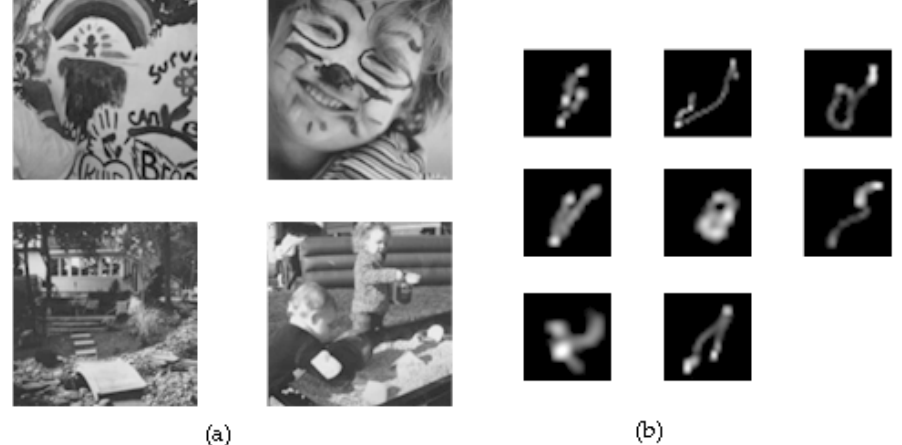
Figure 7. The Levin library; ( a ) the original images from Levin library; ( b ) kernels. Table 6. Final results of total PSNR.